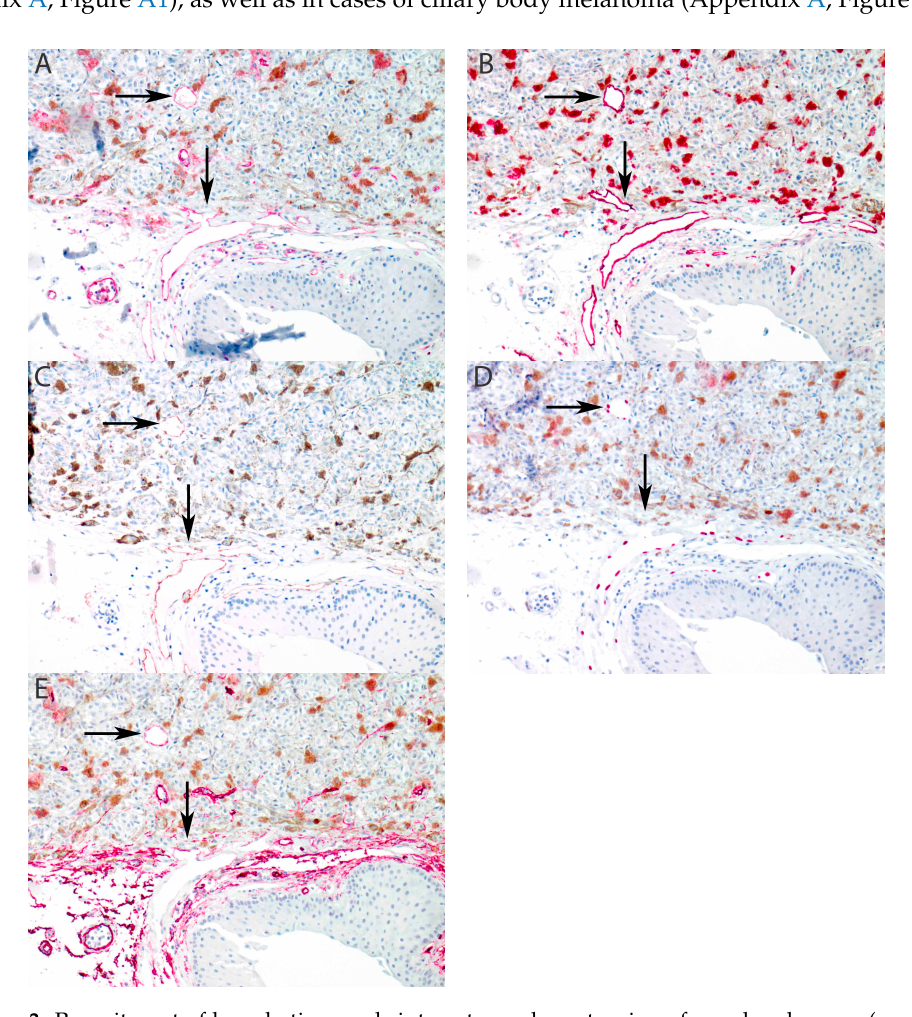
Figure 2. Sample 15 of Table 2: intratumoral focal positive staining of tumor vasculature for LYVE-1. ( A ) CD31 stains all endothelial cells (arrow). ( B ) D2-40 is negative in endothelium. ( C ) LYVE-1 shows focal positive staining in a large tumor vessel. ( D ) Prox-1 is negative. ( E ) CD34 stains all endothelial cells. (All panels: original magnification 400×).